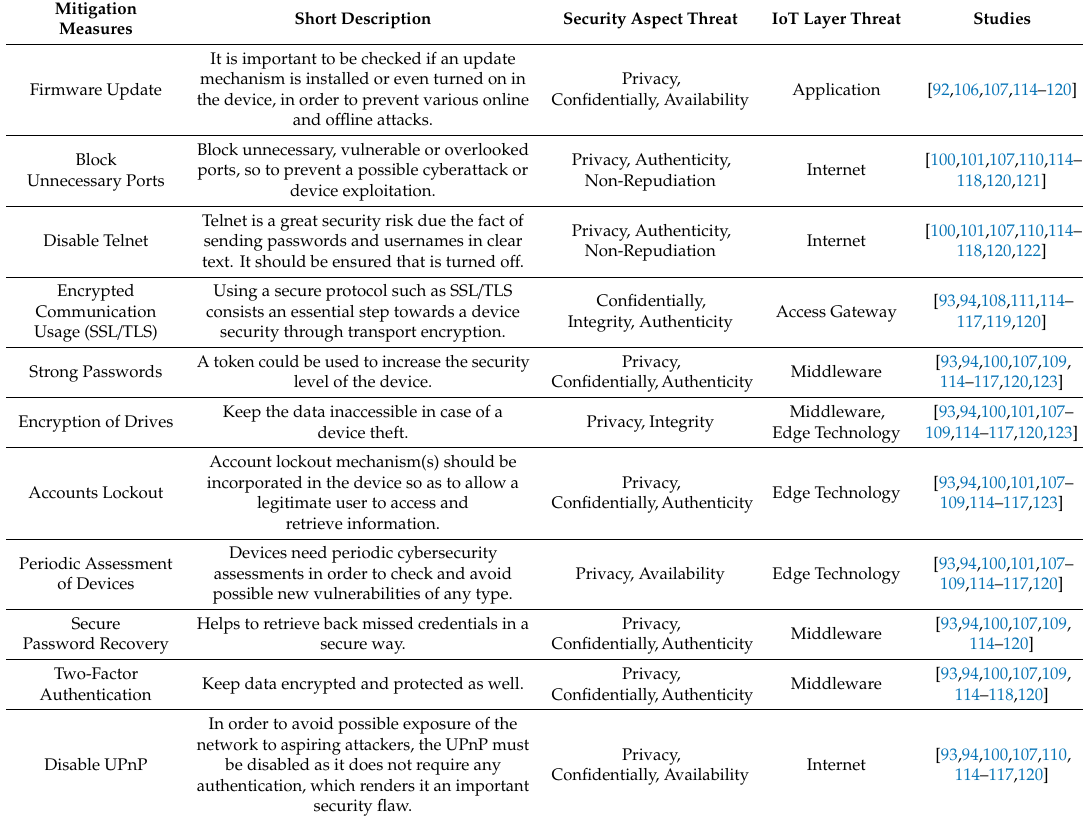
Table 4. Mitigation countermeasures against cybersecurity threats and